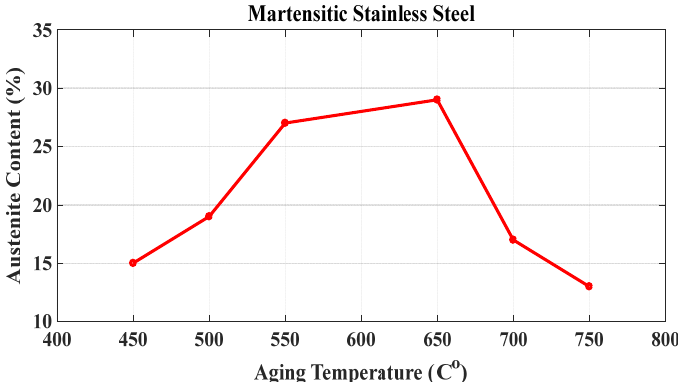
Fig. 3. Effect of four hours aging temperature on volumetric ratio for